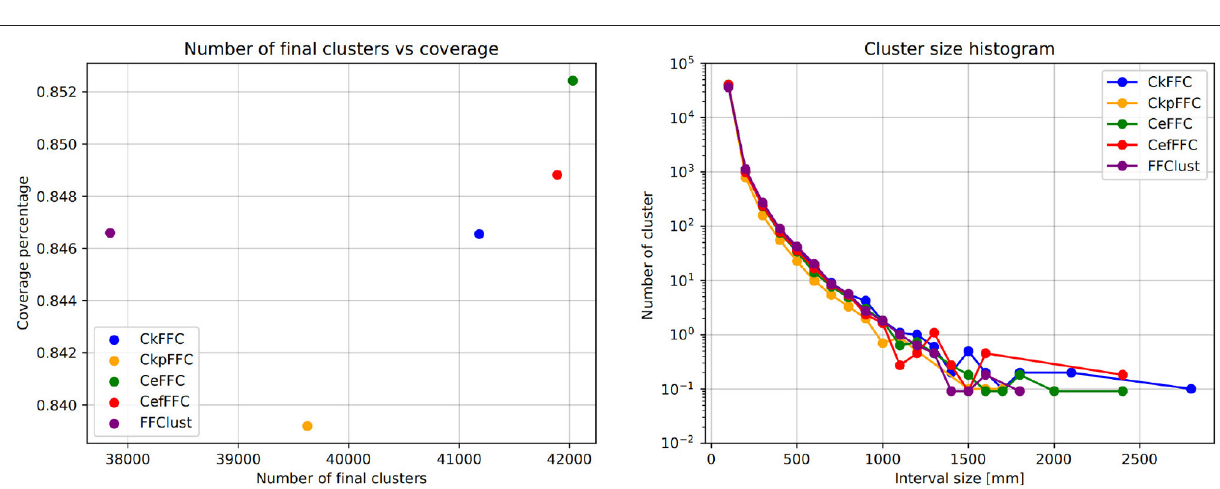
Since our goal is to produce a high-quality clustering algorithm close to FFClust, we define a normalized DB index ( DB n ), which divides the DB index obtained by an alternative algorithm, by the DB index of